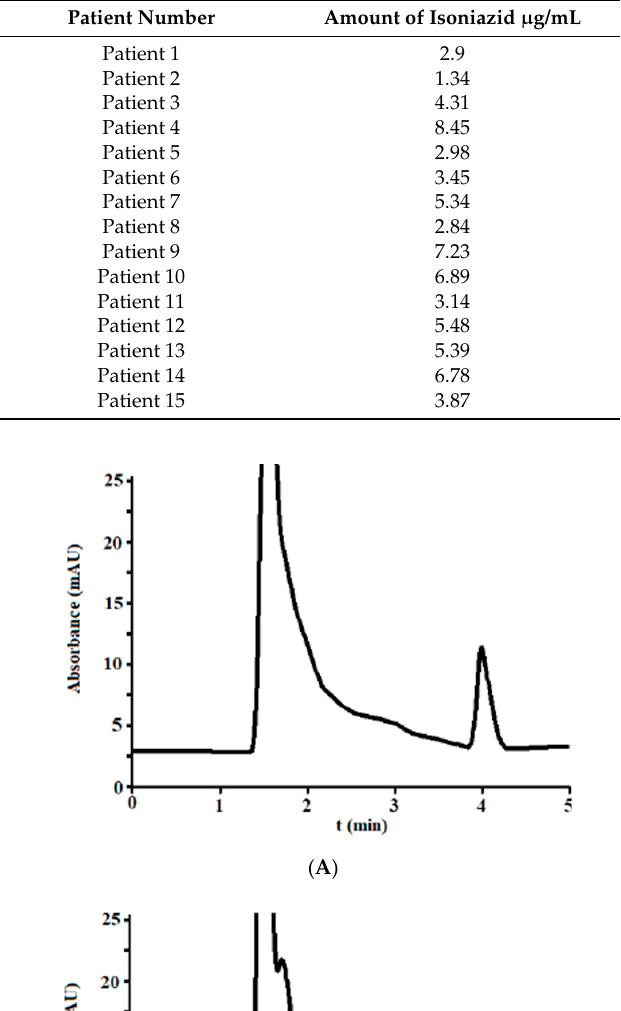
Table 3. Amount of isoniazid found in the urine of 15 tubercular patients.